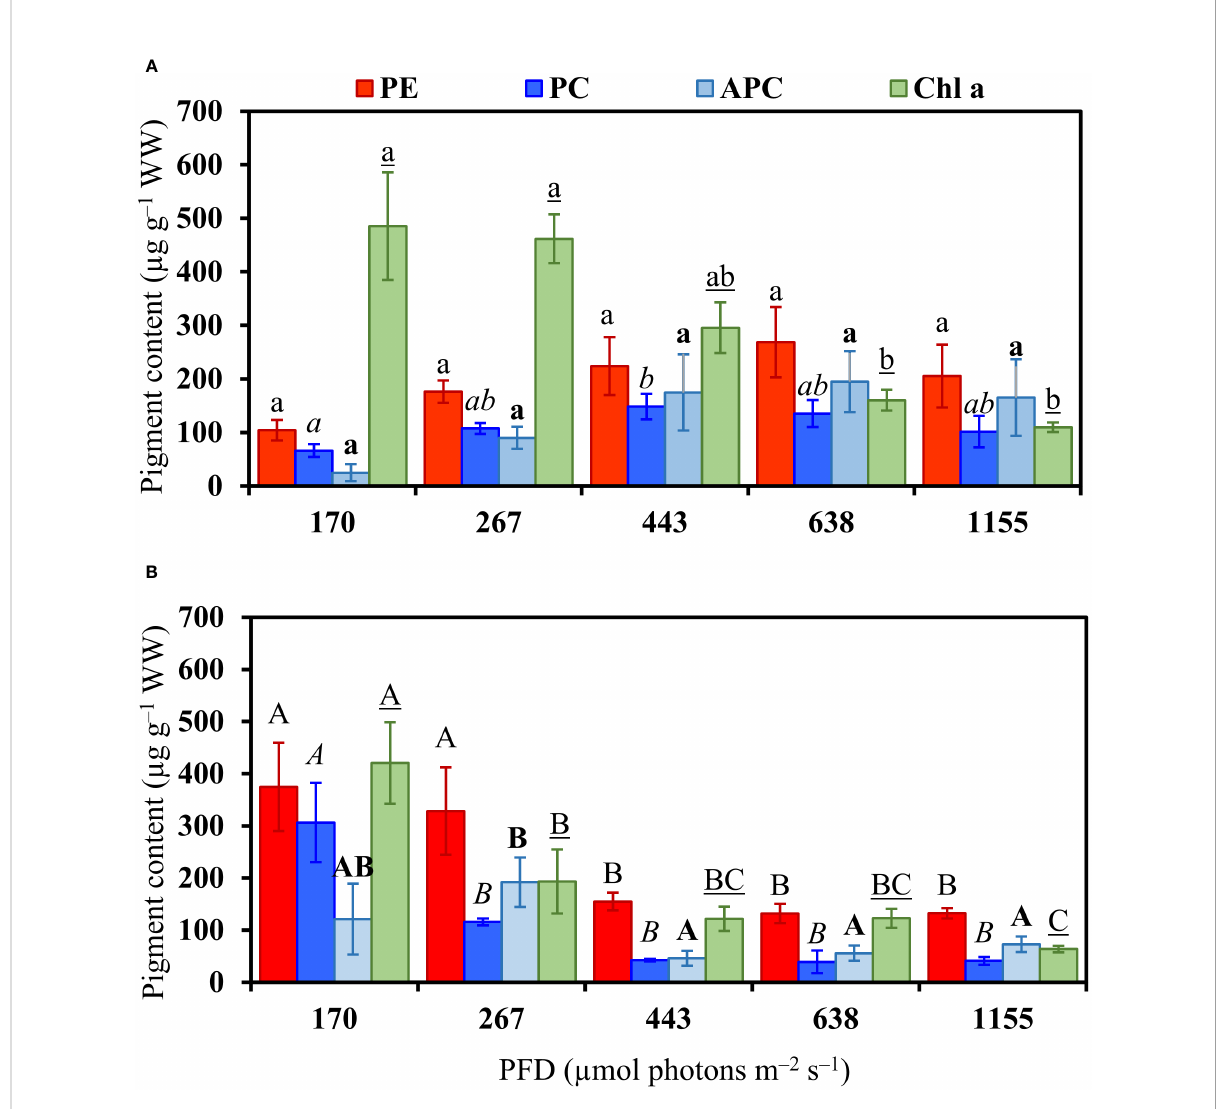
FIGURE 5 Pigment content in Bostrychia calliptera (A) and B. montagnei (B) cultured under different photon fl ux densities (PFDs) for 14 days. Columns are means and bars are standard deviations based on four replicates ( n = 4). PE: Phycoerythrin, PC: phycocyanin, APC: allophycocyanin, Chl a : chlorophyll a. Bostrychia calliptera (A) : different regular, italic, bold, and underlined lowercase letters indicate statistical difference ( p < 0.05) for PE, PC, APC, and Chl a , respectively, among PFD treatments. Bostrychia montagnei (B) : different regular, italic, bold and underlined uppercase letters indicate statistical difference for PE, PC, APC, and Chl a , respectively, among PFD treatments. Statistical differences were found applying one – way ANOVA or Kruskal – Wallis ’ test (Table S1) followed by associated post hoc